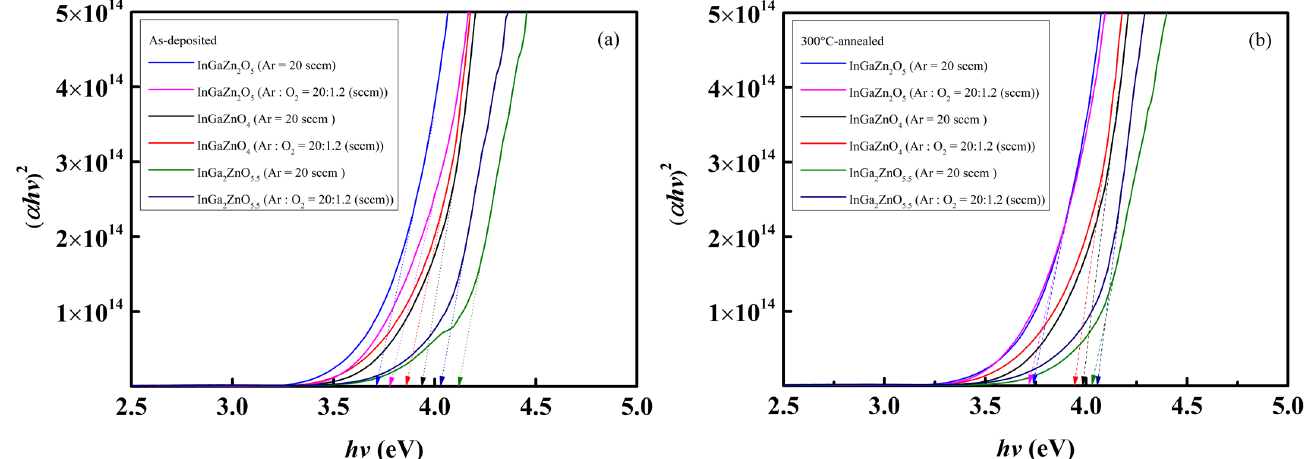
Figure 5. The ( α h ν ) 2 versus h ν plots of ( a ) as-deposited and ( b ) 300 °C-annealed a -IGZO layers deposited with Ar = 20 sccm and Ar:O 2 = 20:1.2 (sccm) gas flow rates.